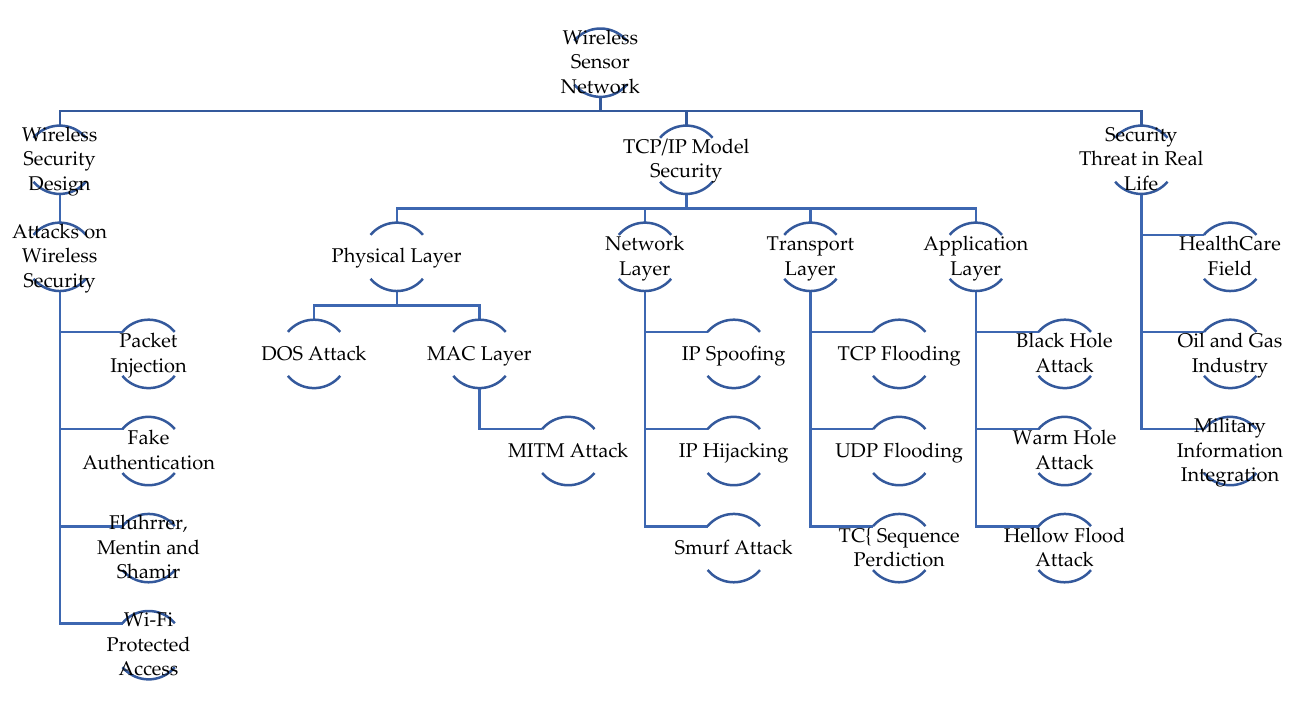
Figure 1. Wireless sensor network components-based security threats with types.